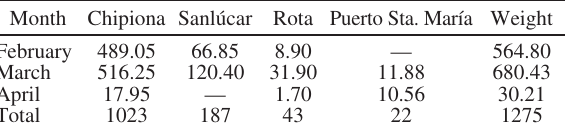
Fig. 4. – Topology of neighbour-joining tree based on 660 bp of the Cox1 gene sequences, showing inferred phylogenetic relationships within the genus Cynoscion . Numbers close to nodes indicate bootstrap support (only values above 50% shown). GenBank accession numbers are shown after name of species. Table 2. – Declared landings (in kg) of C. regalis per month in ports of the Gulf of Cádiz in